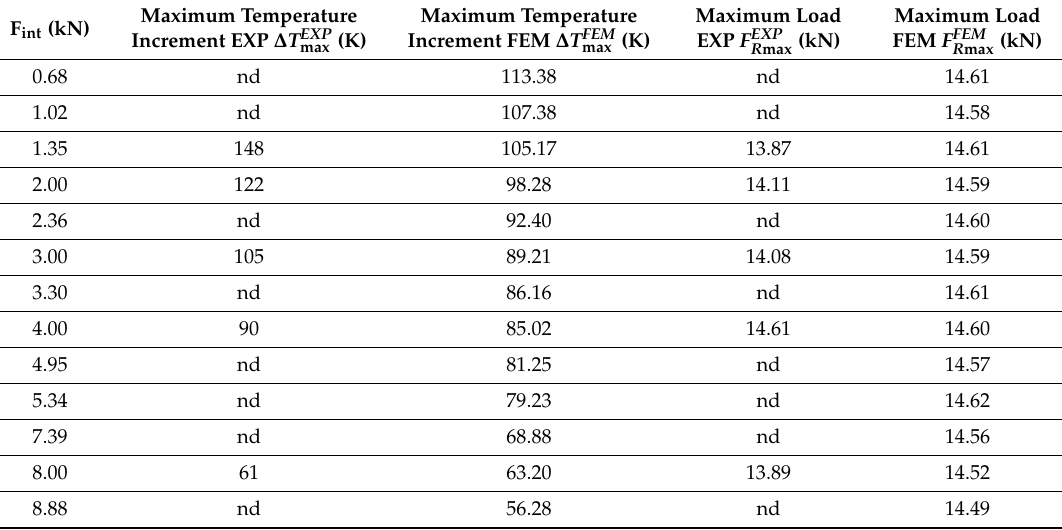
Table 4. The maximum values of the temperature increment and the reaction